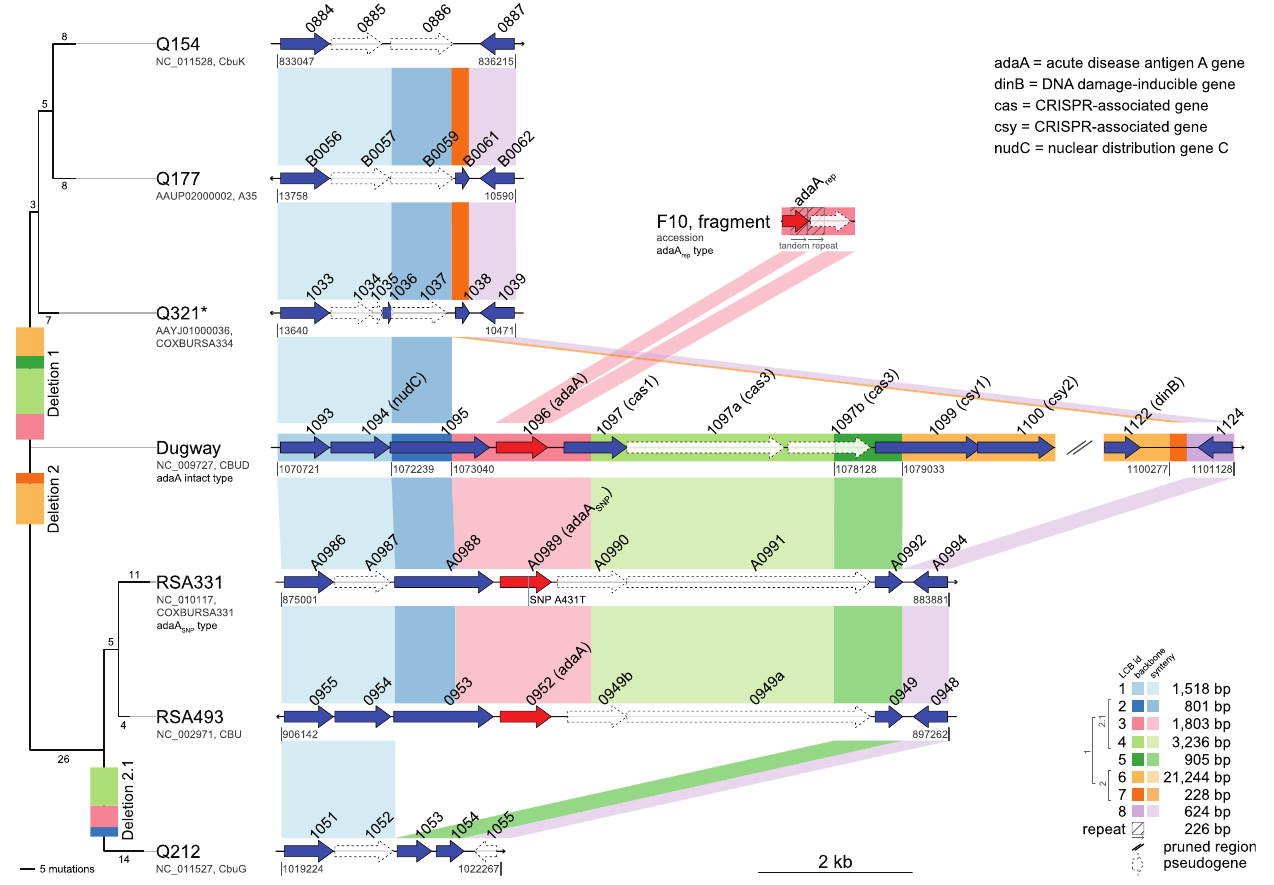
Figure 1. Polymorphisms of the adaA genetic region demonstrated using seven C.burnetii reference genomes. Three deletion events resulting in two main deletion types (Q154 and Q212) and three adaA gene variants ( adaA , adaA SNP and adaA rep ) resulting from independent mutation processes were identified in silico . The organization of the adaA flanking region of the Dugway genome (displayed in the center) is compared to the other six reference genomes. Just for the purpose of visual compactness, the light orange region was pruned between the ORFs CBUD_1100 and CBUD_1122. Gene annotations are obtained from GenBank. Coding genes are drawn in blue, pseudogenes in white and the adaA gene in red. Arrow direction represents the location of the ORFs at the forward and backward strand. Locus tags are shortened by its common prefix and written above the ORFs. If gene names are known, they are written next to their locus tag and in parentheses. Long collinear blocks (LCBs) are shown as colored rectangles at the backbone of the Dugway genome. The pairwise syntenic regions between the genomes are drawn in lighter color, accordingly. The phylogenetic relationship is shown at the left side. Just for visualization purposes, the Dugway genome was rotated to the middle. The length of the branches encodes the number of mutation events. Three different deletions were identified and its affected LCBs are drawn to the phylogenetic branch where the deletion events may have occurred. Dugway and RSA331 were chosen as representative strains to show the intact adaA gene and adaA SNP gene, respectively. A fragment of strain F10 is exposed in the figure to show the inserted repeat variant ( adaA rep ). The figure was drawn using genoPlotR [37]. *Q321 replaces RSA334, which was accidently assigned to the published whole genome data.